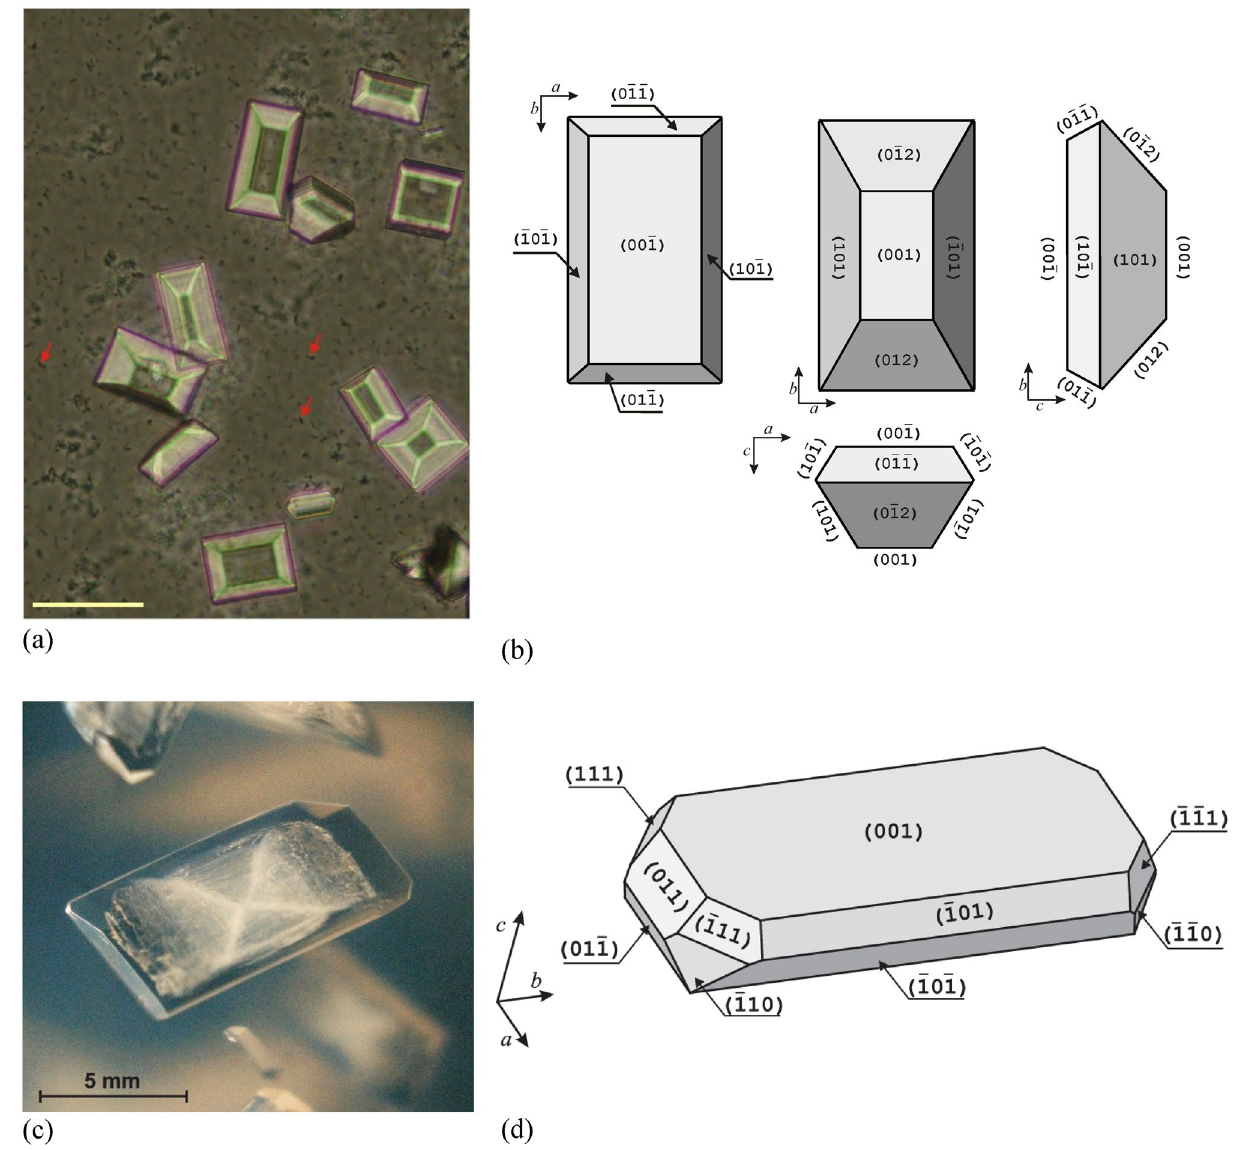
a gel; and ( d ) a schematic representation of its habit with Miller indices of the individual faces. ( a ) reprinted (adapted) with permission from Ref. 24 . Copyright 2023 American Chemical Society; ( c ) and ( d ) reprinted from Ref. 15